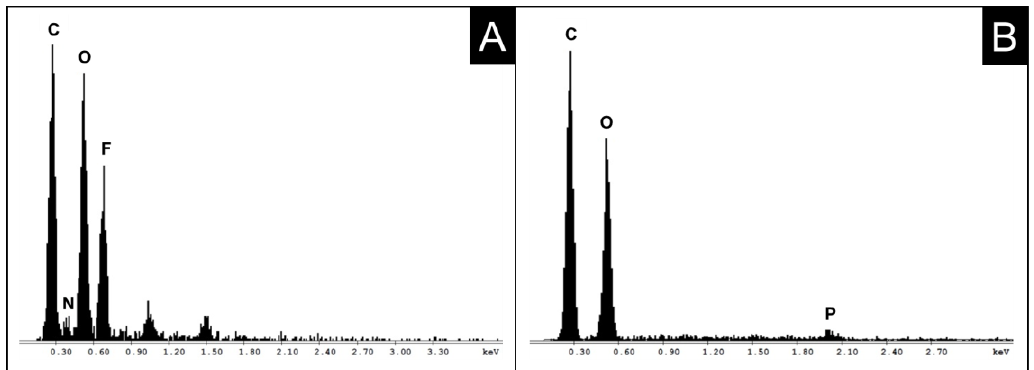
Figure 2. EDAX spectra of aerogels obtained without ( A , non-derivatized CL) and after ( B , phosphorylated CL) implementing a H 2 O washing step prior solvent exchange and scCO 2 drying.